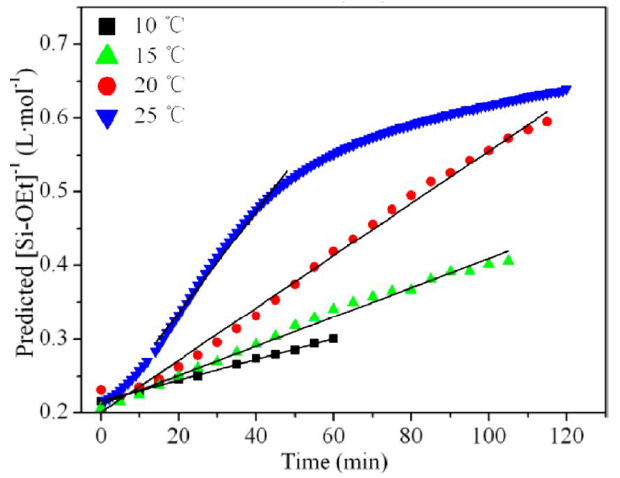
Figure 8. [Si-O-ethyl] − 1 of MTES hydrolysis at different temperatures at [H 3 O + ] = 1.468 × 10 − 4 M. Reprinted with permission from [37]. Copyright American Chemical Society, 2014.